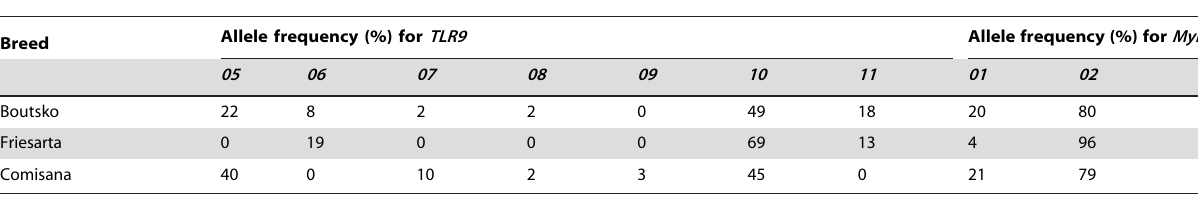
Table 2. Allele frequency of TLR9 and MyD88 genes in three sheep breeds.